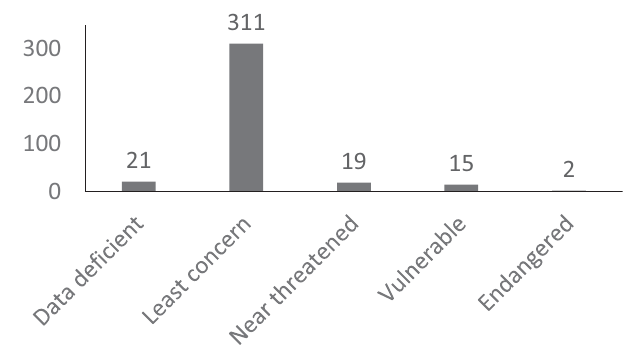
Fig. 2. Indonesian ornamental marine species listed in the IUCN Red List of Threatened Species and their